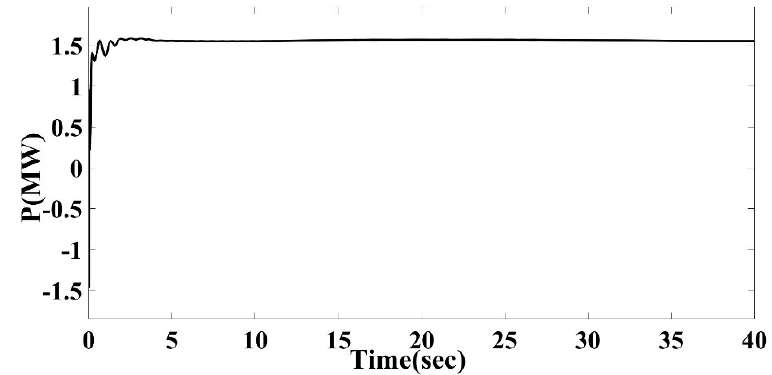
Figure 20. Active power response at 18th iteration.